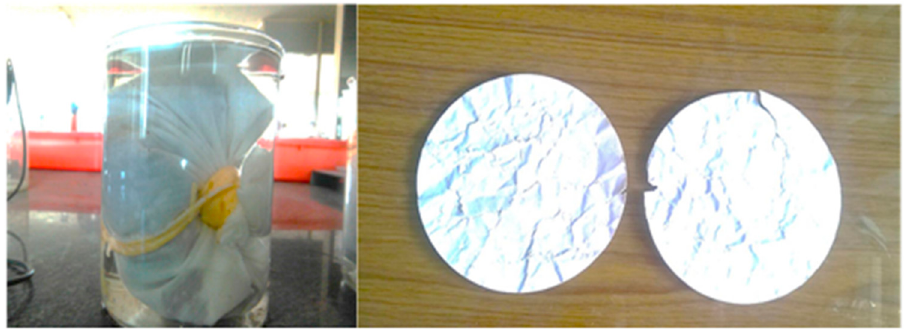
Figure 7. Filter papers without staining.